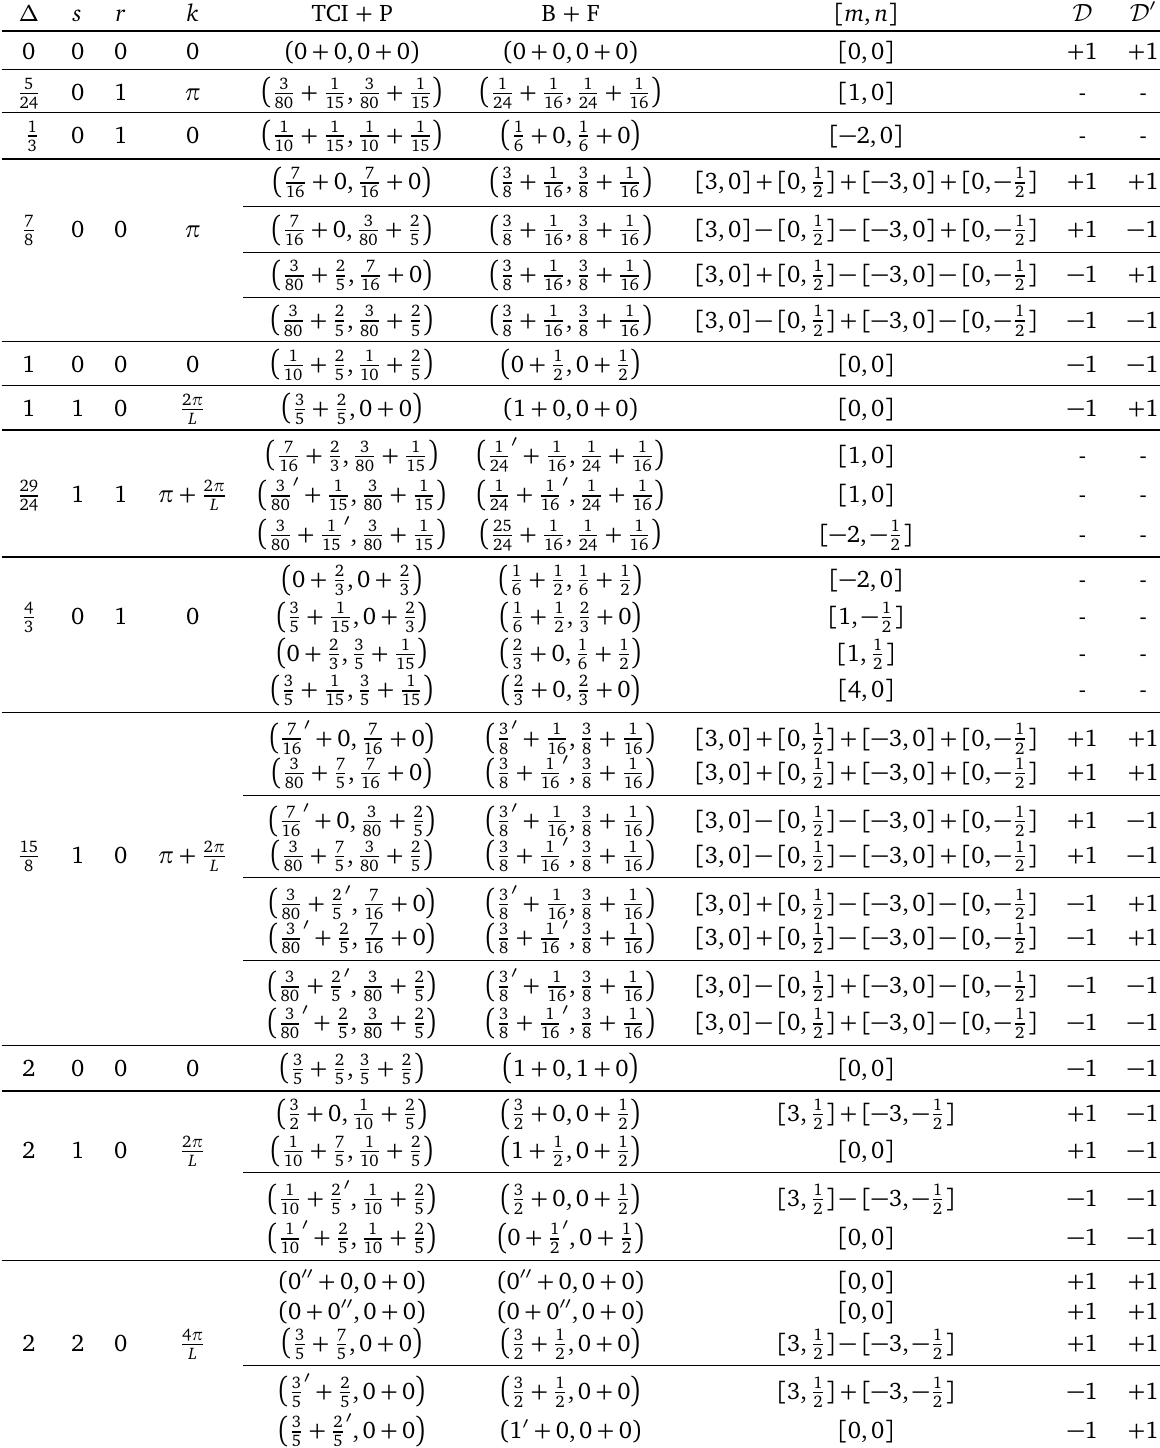
Table 1: The relevant and marginal operators for H ( of the scaling dimensions and the charges are given in the text. A primed dimension denotes the Virasoro raising operator L − dimension, while a double-primed number indicates the action of L − linear combinations of the bosonic and fermion operators are chosen to behave nicely under duality and parity. For operators with charge r = 1 , the corresponding oper- ator with r = − 1 is not given. For fields with k (cid:54) = 0, π , the corresponding operator with momentum − k not